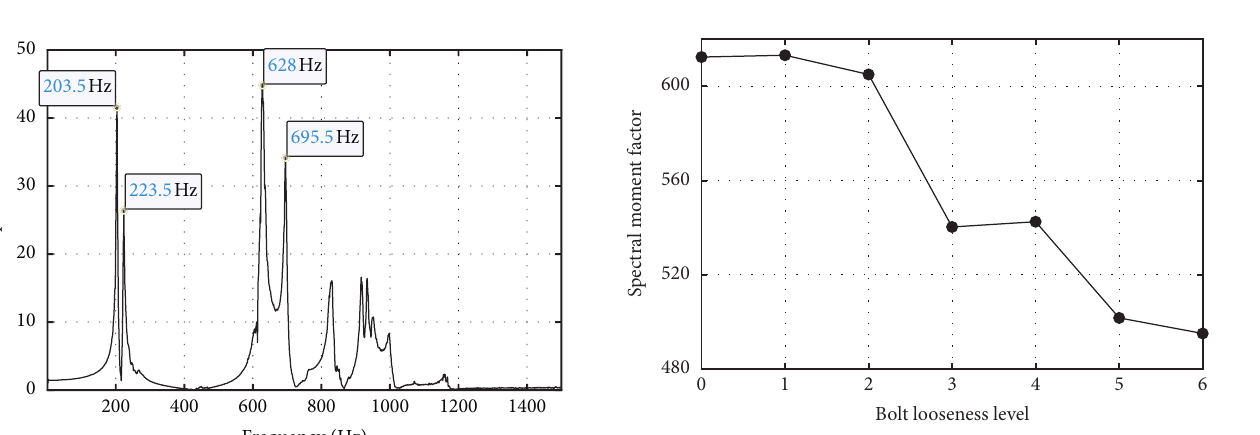
Figure 8: Variation of the spectral moment factor with the bolt looseness